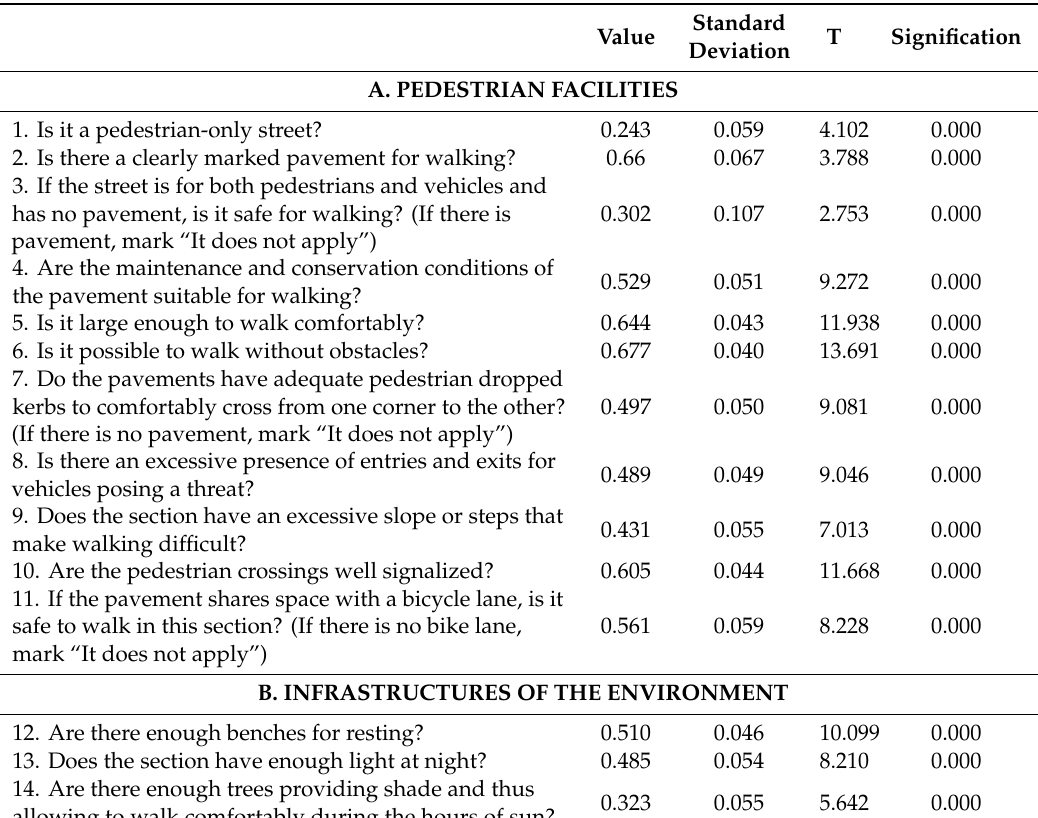
Table 3. Coe ffi cients of Goodman and Kruskal’s gamma correlation between the items of the UWPQ and global assessment of the section (Item